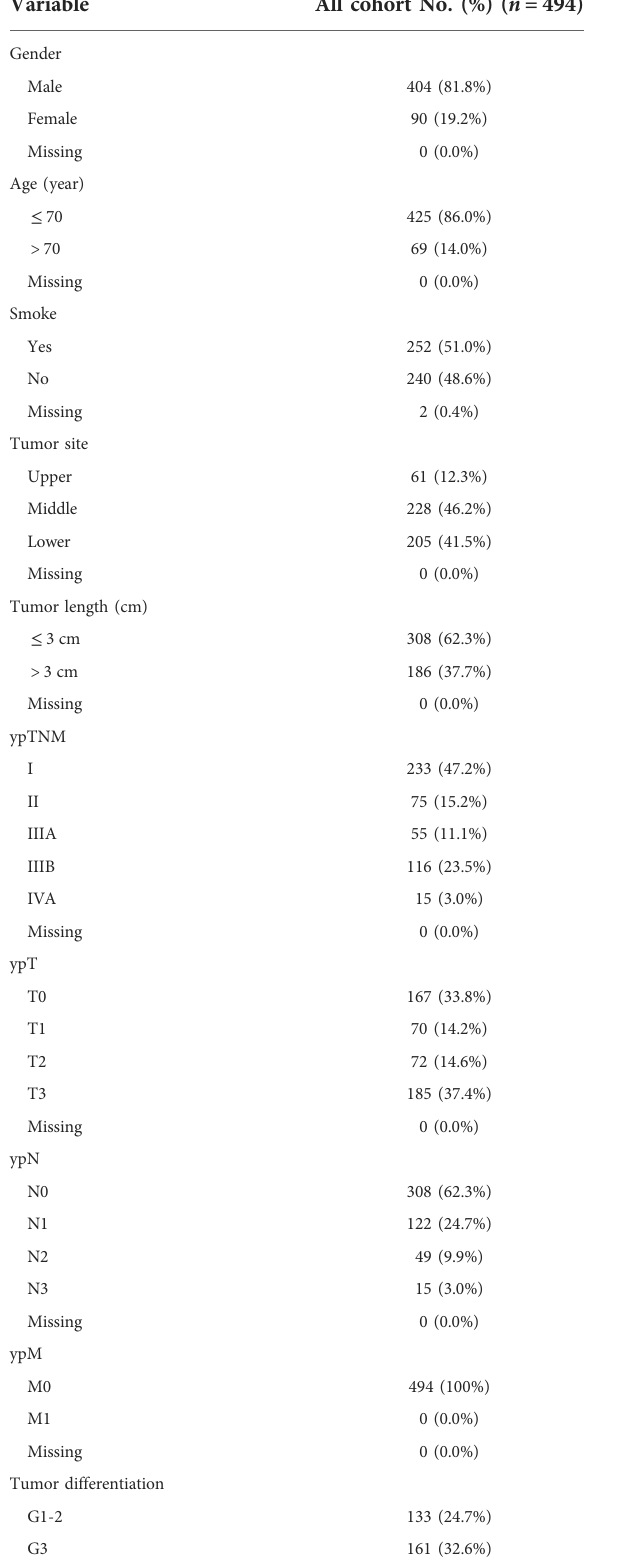
TABLE 1 Patient